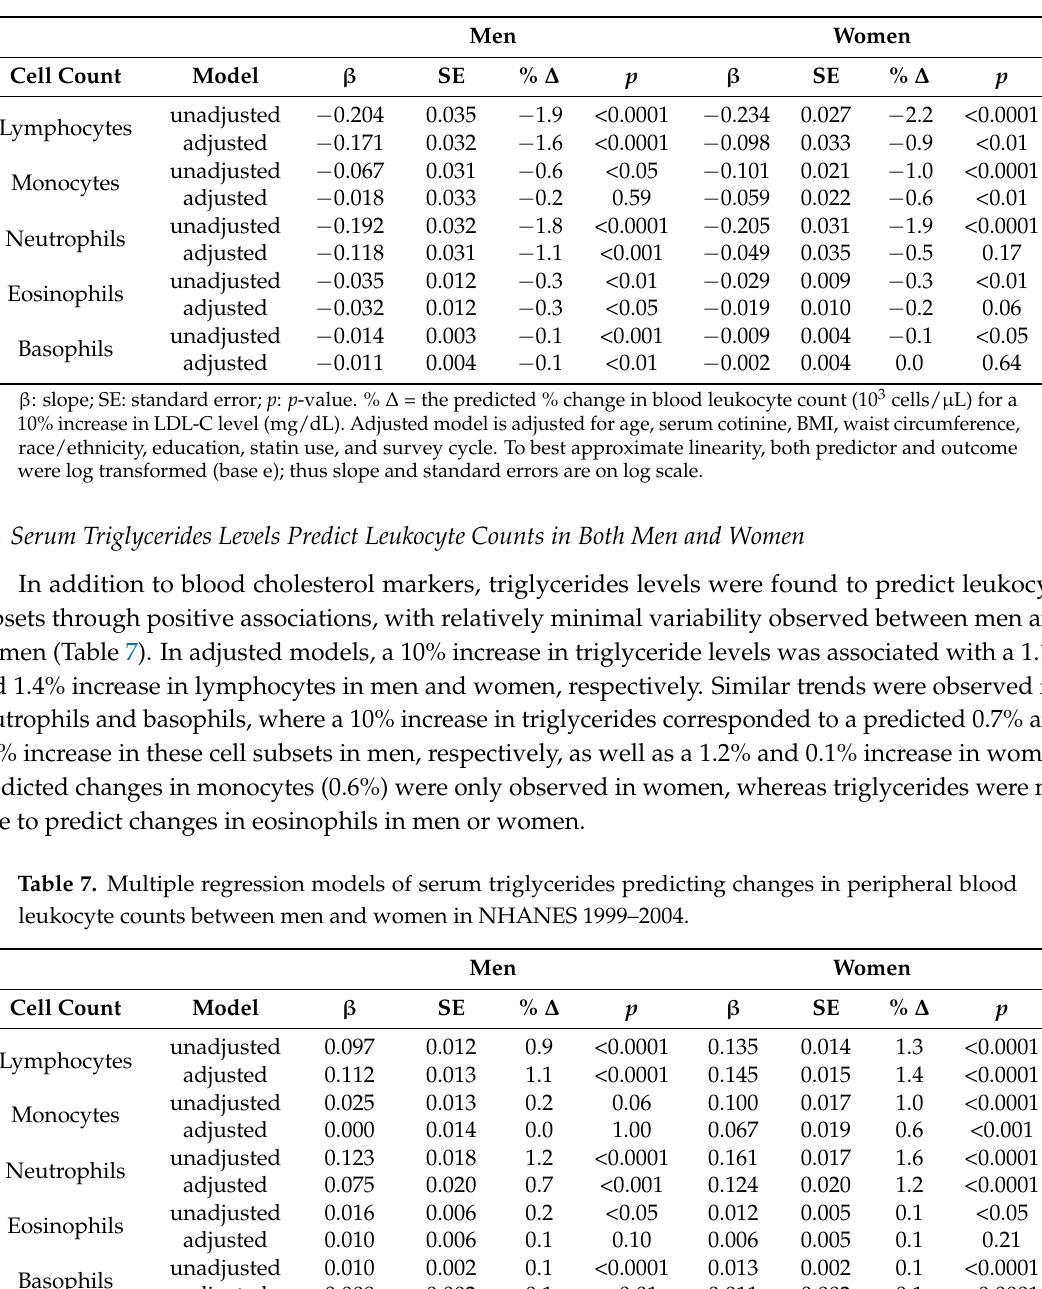
Table 6. Multiple regression models of serum HDL-cholesterol predicting changes in peripheral blood leukocyte counts between men and women in NHANES 1999–2004.